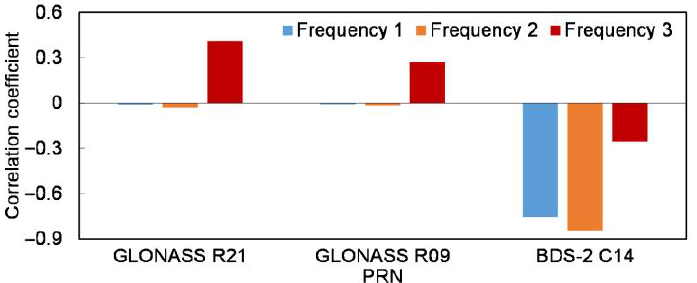
Figure 5. The correlation coefficient between the code pseudorange variations and elevation angle at BRUX station on DOY 325, 2020. The blue, orange, and red bars represent the correlation coefficients in the first, second, and third frequencies, respectively.